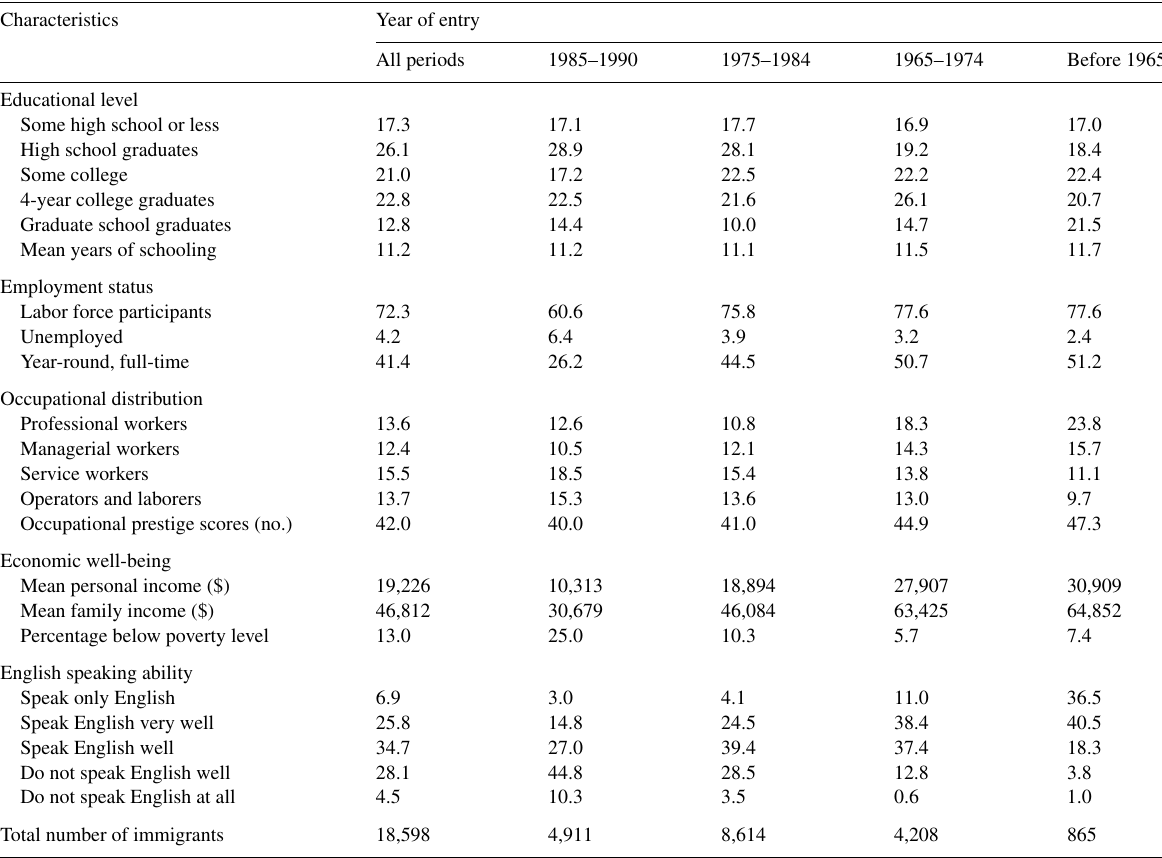
Table 6 Social and economic status of Korean immigrants (percentages)